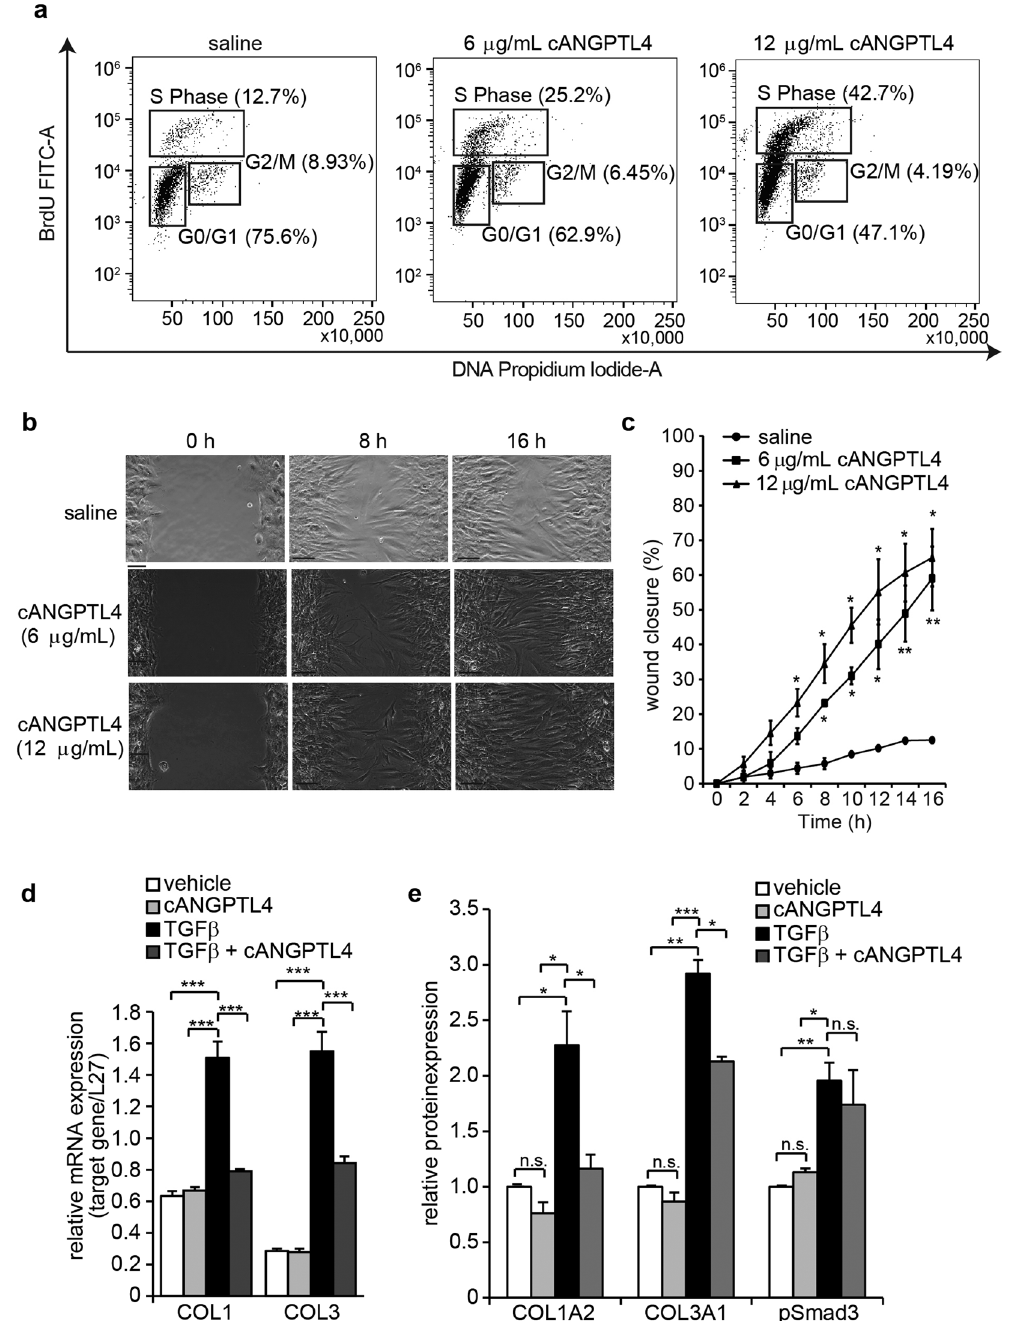
Figure 2. cANGPTL4 enhanced fibroblast proliferation and migration and reduced fibroblast collagen expression. ( a ) Representative FACs scatter plots of fibroblasts subjected to 24 h of the indicated treatments, then pulsed with 40 μ M BrdU for 30 min prior to FAC S analysis. Fibroblasts were harvested and fixed in 70% ice-cold ethanol, their DNA was denatured with 1.5 M HCl, rinsed to neutralize acidity, then stained with FITC- conjugated anti-BrdU antibody and propidium iodide according to manufacturer’s protocol. Cell populations in the G0/G1, S and G2 phases are gated and the percentages are indicated in parentheses ( b,c ) Representative images and measurements of percentage wound closure by fibroblast migration. Human primary dermal fibroblasts (1 × 10 4 cells per insert) were seeded into silicone inserts (ibidi, USA) on a 24-well culture plate (Corning Life Sciences, USA) and allowed to attach overnight in a humidified incubator with 5% CO 2 at 37 °C before the removal of the inserts. Fibroblasts were then pre-treated with mitomycin-C (1 mg/mL of culture media) for 2 h to induce cell cycle arrest prior to the start of the scratch assay. Culture medium was replaced with fresh media containing the indicated treatments. The plate was then placed into the Cell-IQ machine for real-time imaging. Wound closure rate was assessed using the on-board analysis software that measured the percentage change in surface area occupied by fibroblasts. ( d ) Relative mRNA expression of COL1 and COL3 in fibroblasts treated for 24 h with vehicle (saline) or 12 μ g/mL cANGPTL4 in the presence or absence of 10